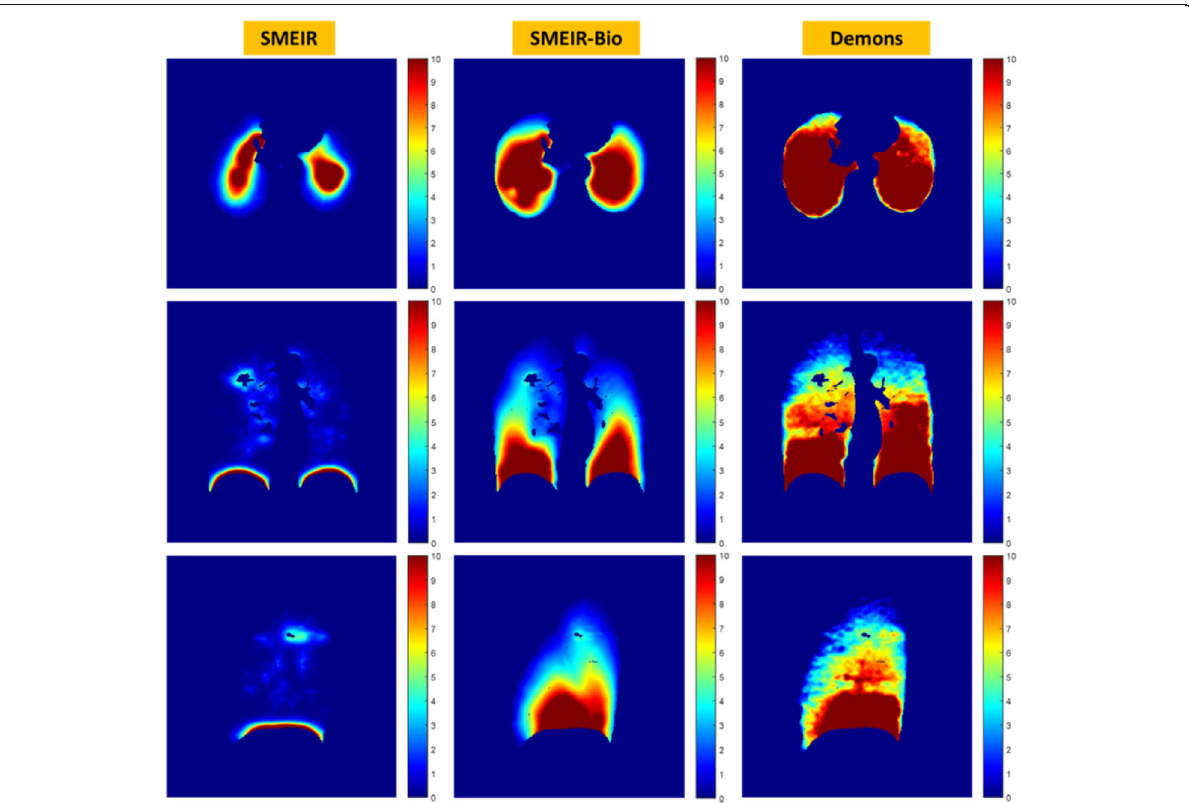
Fig. 6 Comparison of DVFs solved by SMEIR, SMEIR-Bio and the Demons registration. The Demons registration was directly performed between the “ Ground-truth ” high-quality 4D-CT images. SMEIR: Simultaneous motion estimation and image reconstruction; SMEIR-Bio: Biomechanical modeling-guided SMEIR; DVF: